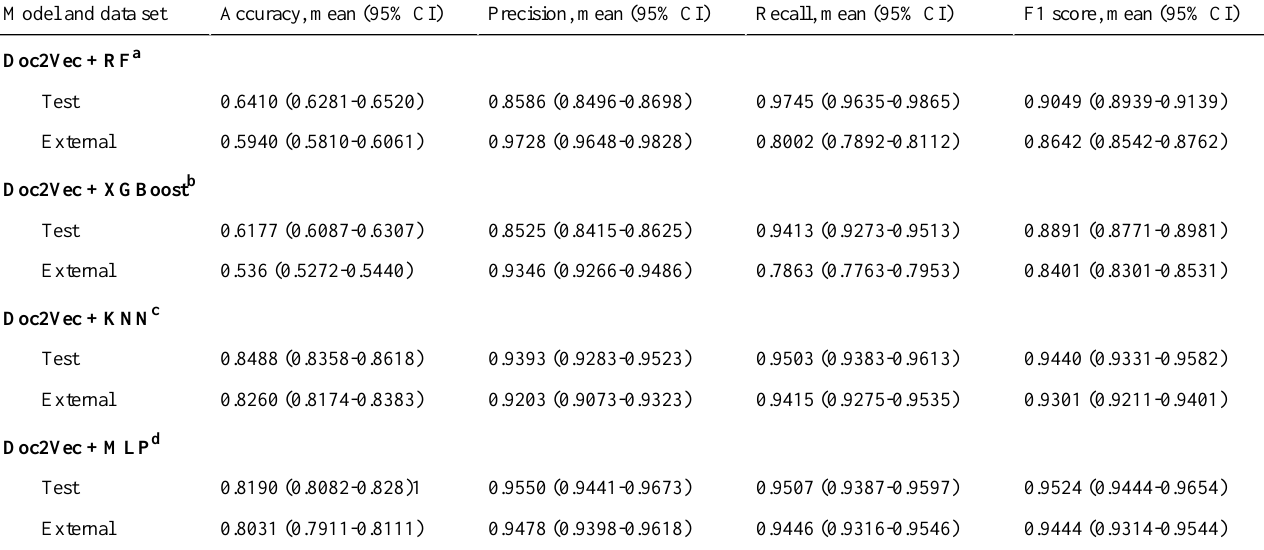
Table 4. Performance analysis of model-based reasoning methods in combination with rule-based reasoning methods applied for syndrome pattern diagnosis of lung disease based on Doc2Vec in the test and external data sets.